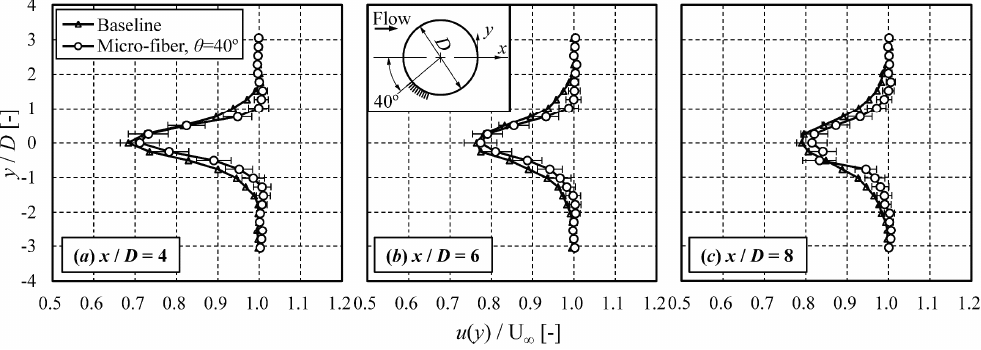
Figure 5. Comparison of mean velocity profiles in wake for baseline and microfiber at θ = 40°: ( a ) x / D = 4; ( b ) x / D = 6; ( c ) x / D = 8. ( a ) x / D = 4; ( b ) x / D = 6; ( c ) x / D =